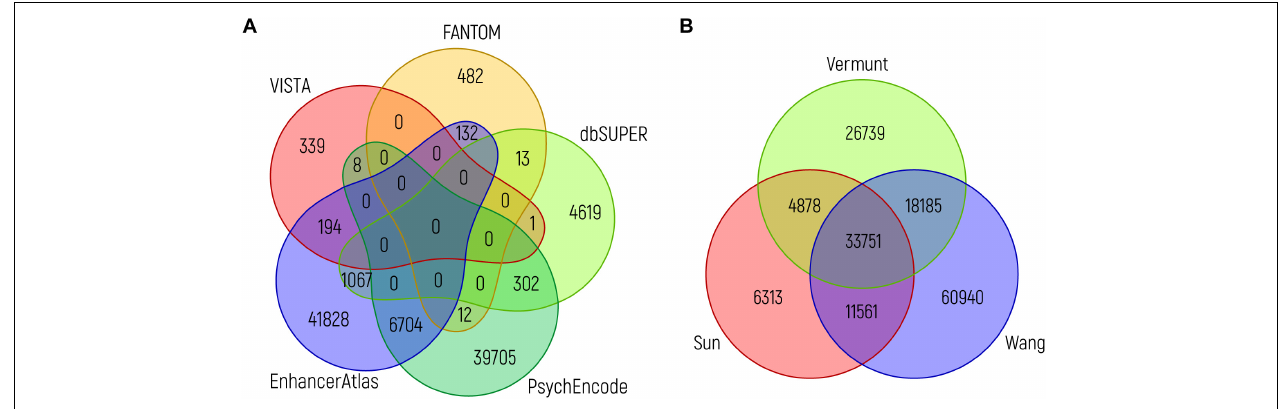
FIGURE 4 | Overlap between brain enhancer databases. (A) Venn diagram showing the overlap between brain enhancers (in genome build hg19) from different databases: VISTA ( n = 542) (Visel et al., 2007), dbSUPER ( n = 6002) (Khan and Zhang, 2016), FANTOM5 ( n = 639) (Andersson et al., 2014), PsychENCODE ( n = 46731; the 46735 enhancers mentioned in the text are in genome build hg38 and the difference of four loci is due to liftover to hg19) (Amiri et al., 2018) and EnhancerAtlas 2.0 ( n = 49925) (Gao et al., 2016). (B) Venn diagram showing the overlap between ChIP-seq peaks for H3K27ac from adult brain, as identified in three studies: Sun ( n = 56503) (Sun et al., 2016), Vermunt ( n = 83553) (Vermunt et al., 2014), and Wang ( n = 124437) (Wang D. et al., 2018). The intersection between different sources (in the same order as above) was performed using bedops and bedtools. In both graphs, the minimum overlap of a single nucleotide is